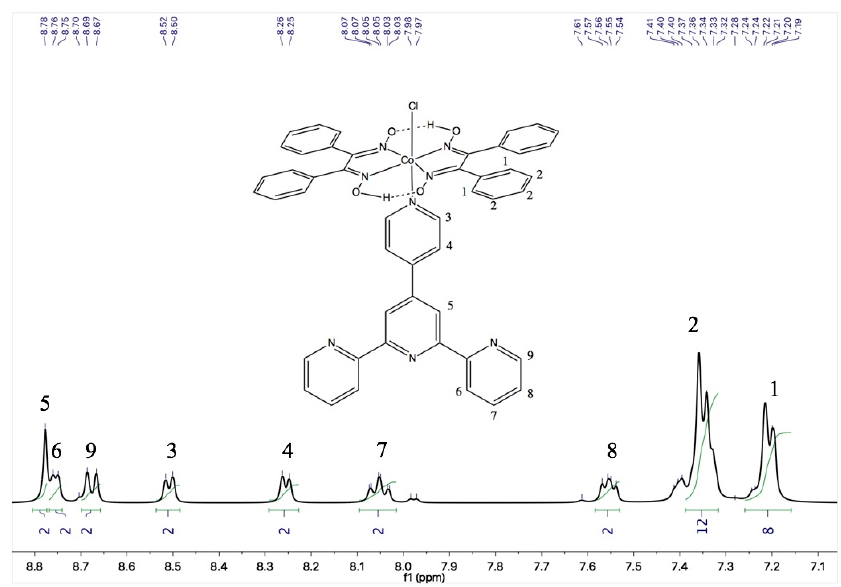
Figure 2. 1 H-NMR spectrum for [CoCl(dpgH) 2 (pytpy)] recorded in DMSO-d6. The insertion of this